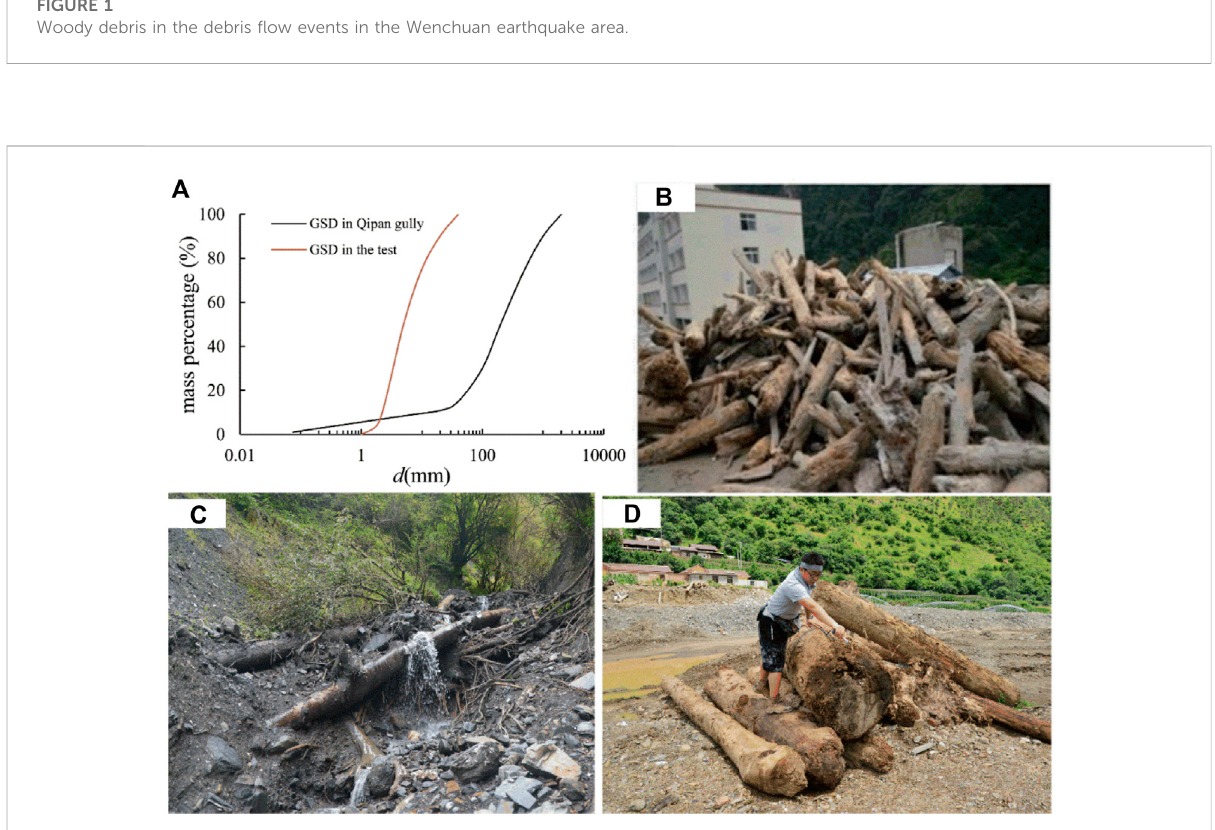
FIGURE 2 LWtransportedbythedebris fl owoccurredon11July2013inQipanGully, (A) GSDofthesedimentinthedeposits, (B) LWarti fi ciallycollectedat the mouth of the main valley, (C) LW in the tributary channel, and (D) the measurement of